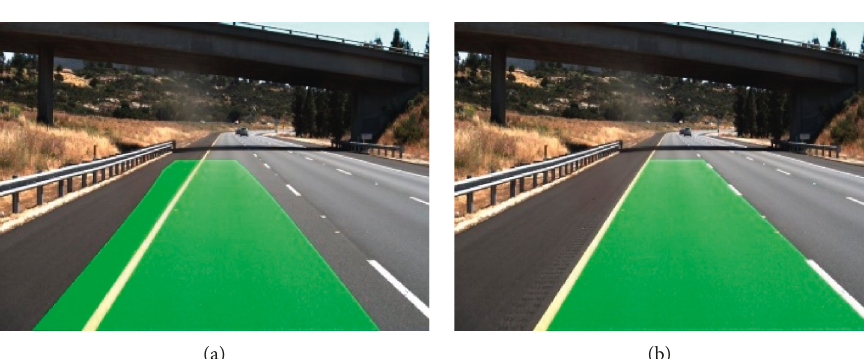
Figure 21: Result of lane detection with window sizes of (a) 50 pixels and (b) and 100 pixels in the TuSimple